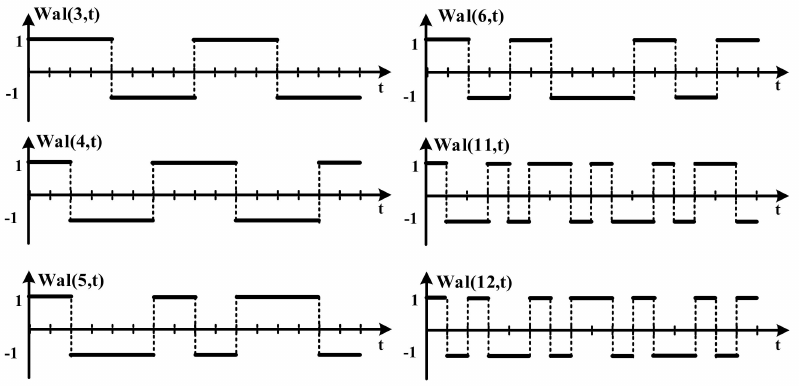
Figure 6. The used Walsh code in the OFDM